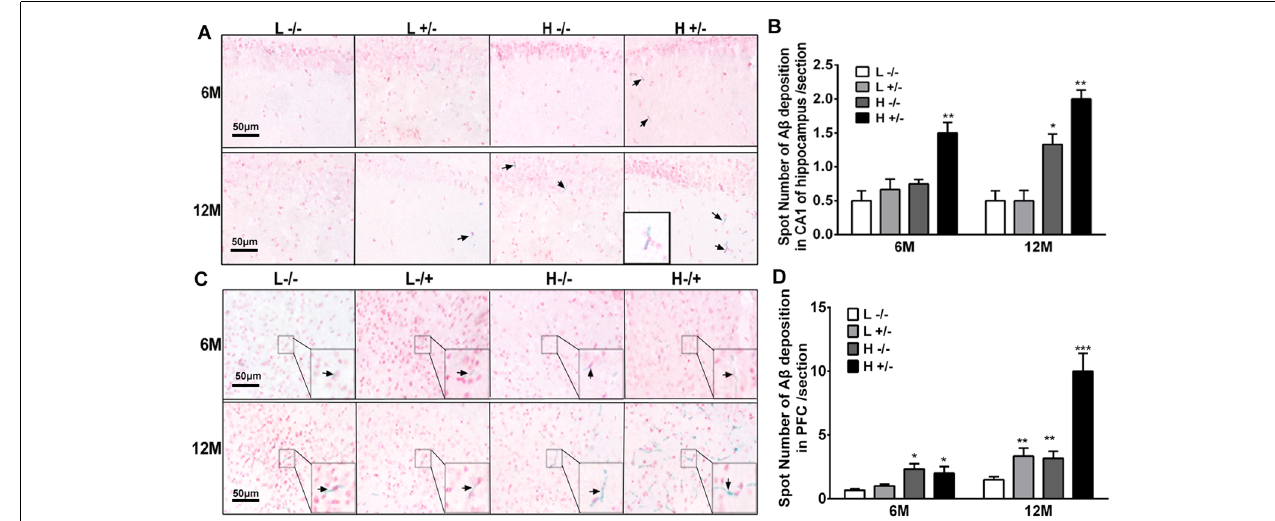
FIGURE 5 | A β 42 deposition in the hippocampi and prefrontal cortexes of hIAPP − / − and hIAPP − / + mice were enhanced by a high-fat diet. (A) Representative images of A β 42-positive staining in the hippocampal CA1 regions of hIAPP − / − and hIAPP + / − mice treated with a high/low-fat diet for 6 or 12 months. Black arrows indicate A β 42-positive particles. (B) Six sections per mouse were stained, and semiquantitative analysis was performed using ImageJ software. (C) Representative images of A β 42-positive staining in the prefrontal cortexes of hIAPP − / − and hIAPP + / − mice treated with a high/low-fat diet for 6 or 12 months. Black arrows indicate A β 42-positive particles. (D) Six sections per mouse were stained, and semiquantitative analysis was performed using imageJ software. L − / − denotes hIAPP − / − mice on a low-fat diet; L + / − denotes hIAPP + / − mice on a low-fat diet; H − / − denotes hIAPP − / − mice on a high-fat diet; H + / − denotes hIAPP + / − mice on a high-fat diet.